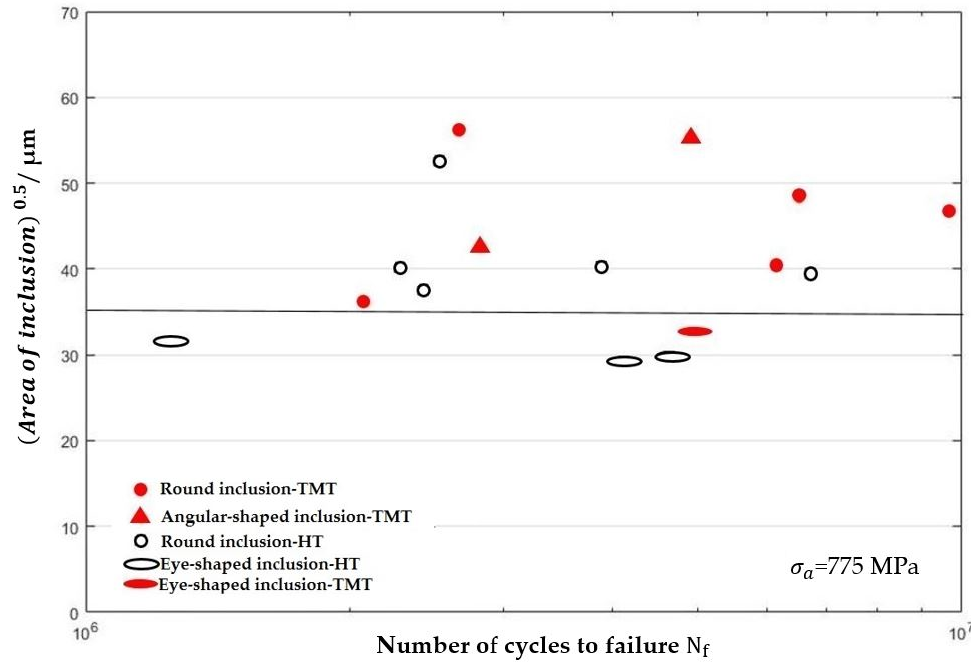
Figure 7. Area of critical inclusions for specimens with TMT and HT versus lifetime at σ a = 775 MPa.